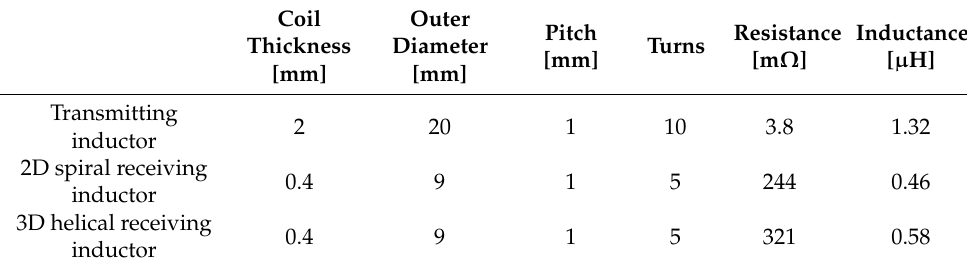
Table 1. Key dimensions and measured parameters of transmitting and receiving